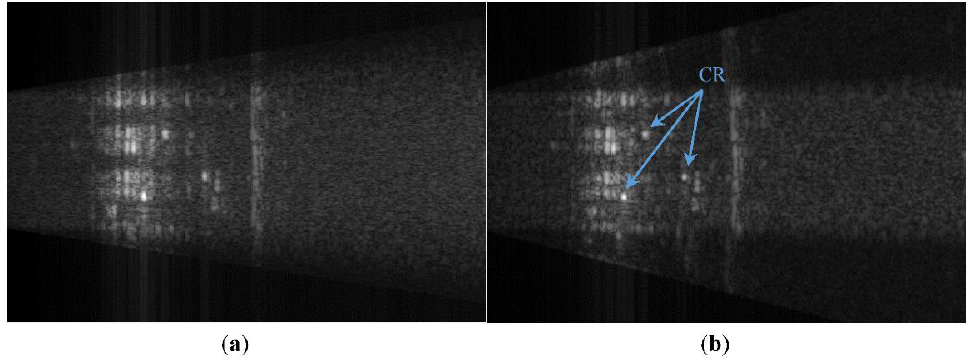
Figure 5. Bistatic GB-SAR focused image by ( a ) range-Doppler algorithm (RDA) and ( b ) back- projection algorithm (BPA) for B = 0.27 m. CR represents trihedral corner reflector.